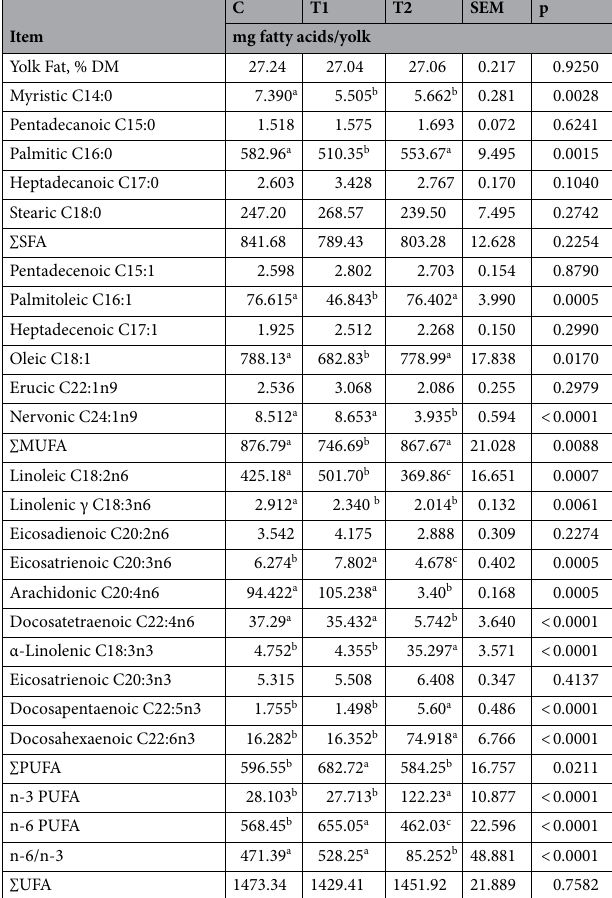
Table 2. Effect of dietary by-products on the egg yolk fatty acids profile. SFA saturated fatty acids, MUFA monounsaturated fatty acids, PUFA polyunsaturated fatty acids, n-6 omega 6 fatty acids, n-3 omega 3 fatty acids, UFA unsaturated fatty acids, C control diet, T1 control diet with 9% rapeseed meal and 3% grapeseed meal, T2 control diet with 9% flax meal and 3% buckthorn meal, SEM standard error of the mean, p significance. abc Mean marked with a different superscript letter within each column are significantly